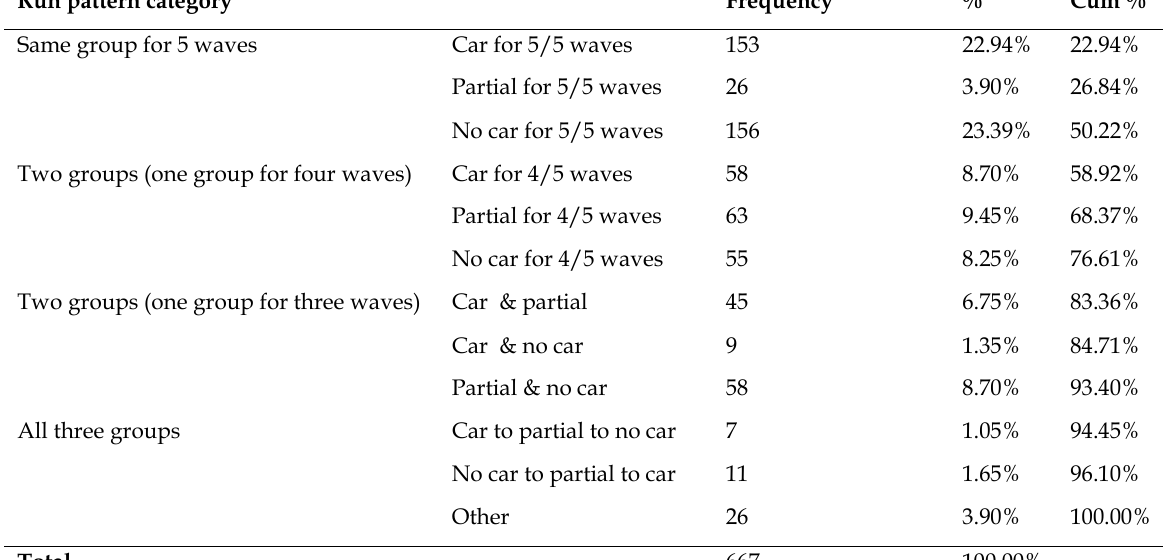
Table 12. Run pattern categories for balanced panel members Run pattern category Frequency Same group for 5